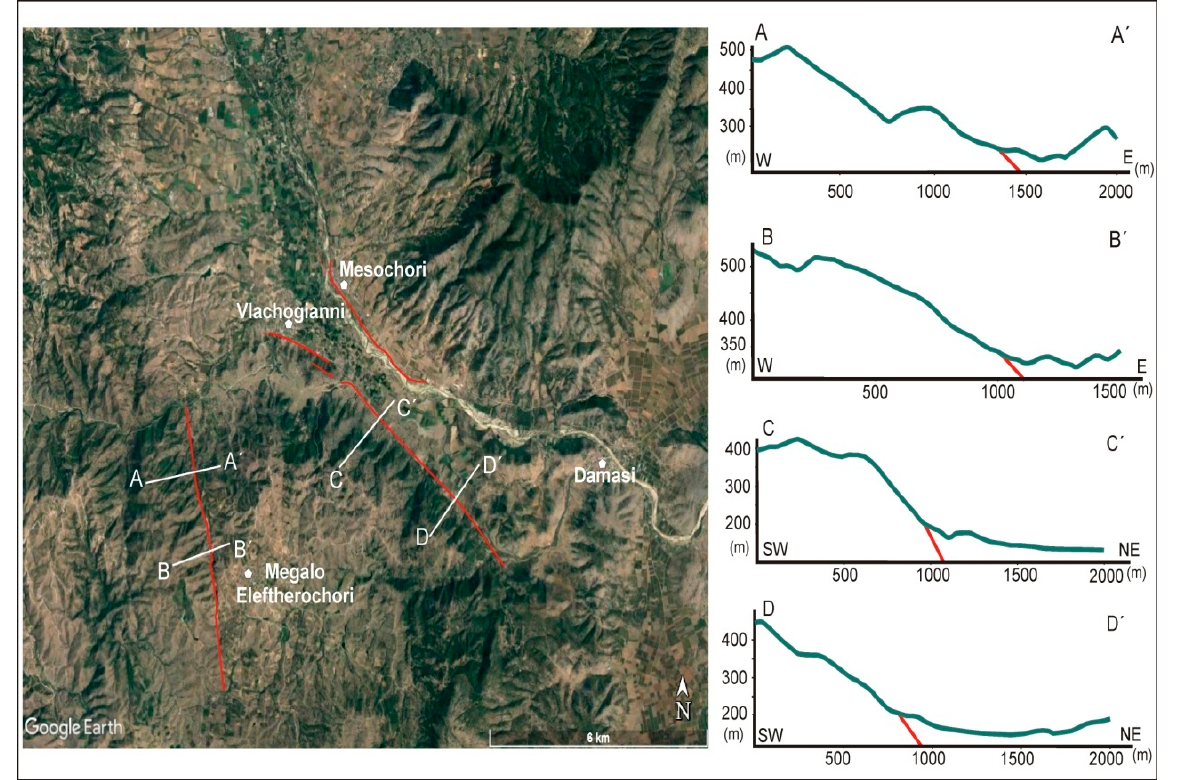
Figure 14. Sections along MeF (AA’ and BB’) and VF (CC’ and DD’) mountain fronts. Mountain front facets on the MeF are primarily triangular. Steeper and wider facets are found in the central part of the fault, where different generations are observed, while their height decreases towards the south. The triangular facets are plotted from 1974 air photos printed at a scale of 1:18,000. The Pf index calculated from these images reaches 78% (Figure 15). northwest, as clearly observed on 1960 air photos (1:15,000 scale). The steepest facets are found along the central part in correspondence of the ground ruptures formed due to the March event. The Pf index for the VF is 87% (Figure 15). Triangular shaped facets, which generally form by erosion of fault-bounded mountain ranges, are arguably one of the most prominent geomorphic features on active normal fault scarps ([18,42]). This evi- dence indicates that the VF had a recent (Late Quaternary) activity, likely characterized by distinct tectonic pulses as suggested by the higher (and older) triangular facets.